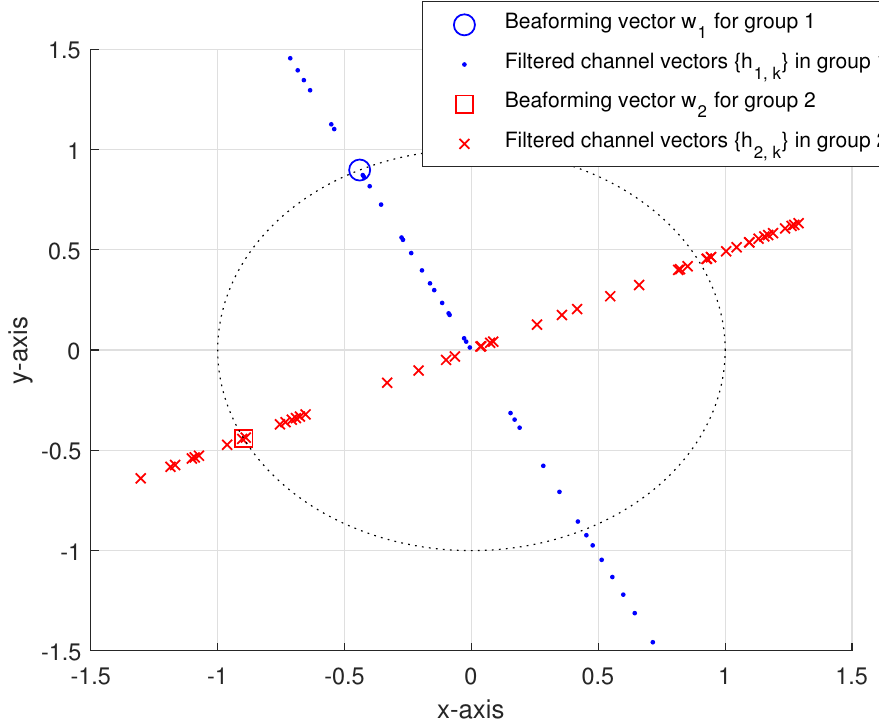
Figure 1. Beamforming vectors { w k } determined by Algorithm 1 and filtered channel vectors { h k , n } of the users when K = M = 2 and N =